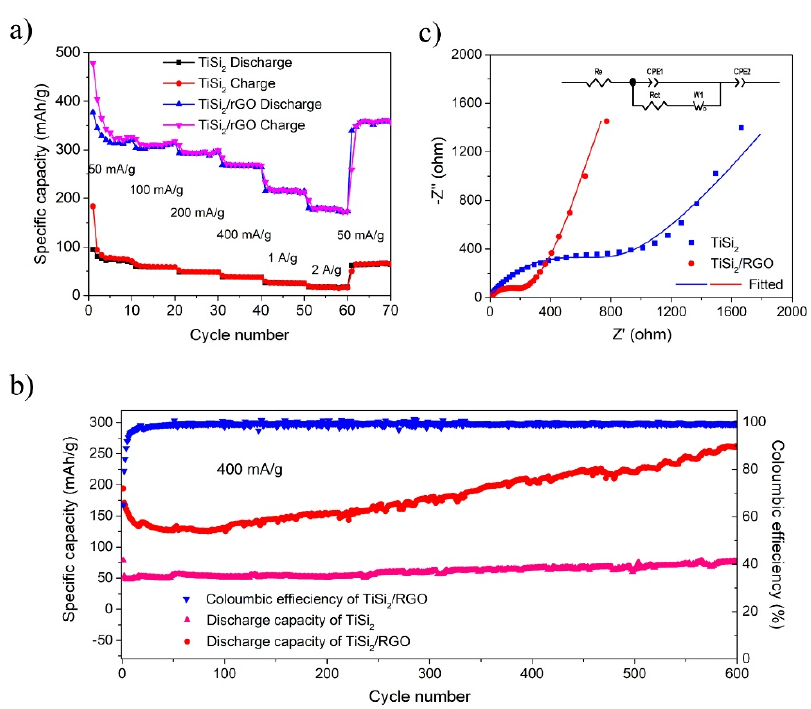
Figure 3. ( a ) rate performance of TiSi 2 and TiSi 2 /RGO; ( b ) cycle performance and coulombic efficiency of TiSi 2 and TiSi 2 /RGO at a current density of 400mA/gt; ( c ) Nyquist plots of TiSi 2 and TiSi 2 /RGO.